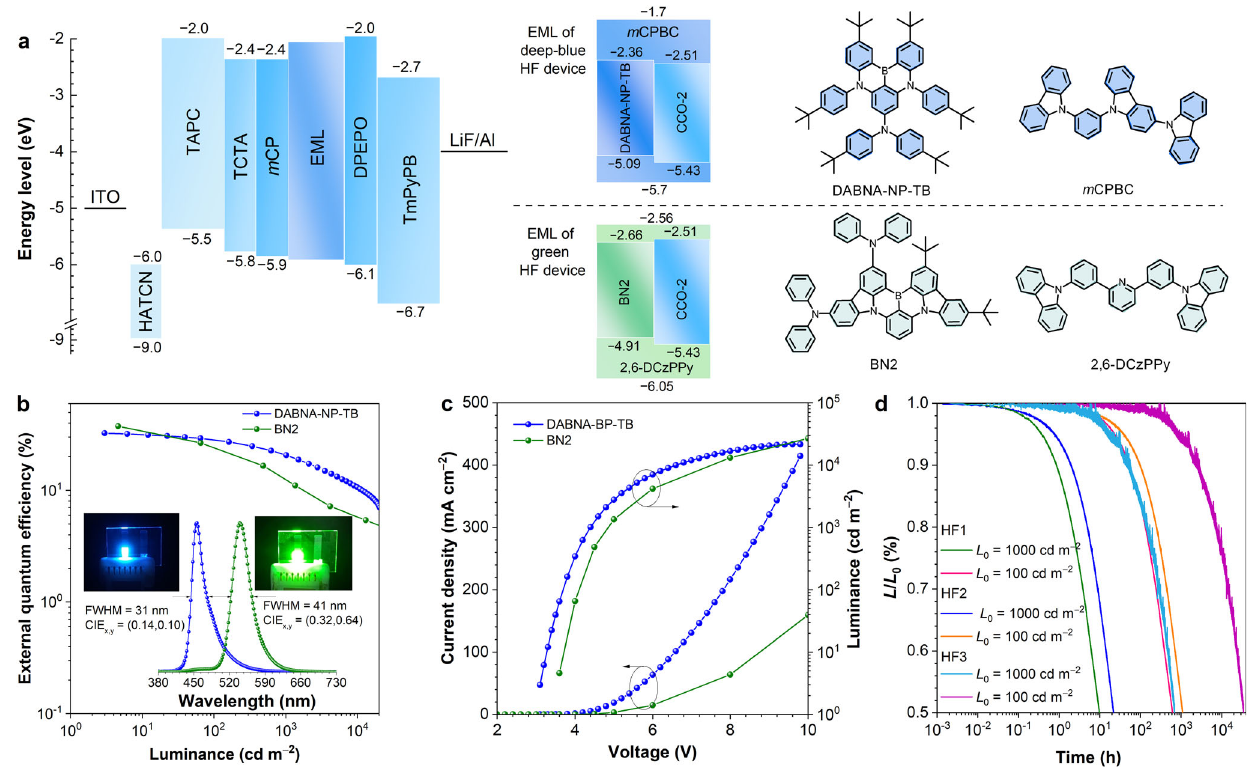
Fig. 5 | EL performance of HF OLEDs. a Device architecture, energy diagram and molecularstructuresofdeep-blueandgreenHFOLEDs.TheLUMOenergylevelsof DABNA-NP-TBandBN2arethereporteddata,calculatedbytheHOMOenergylevel plus optical band gap 49,51 . To maintain consistency of the calculation method of